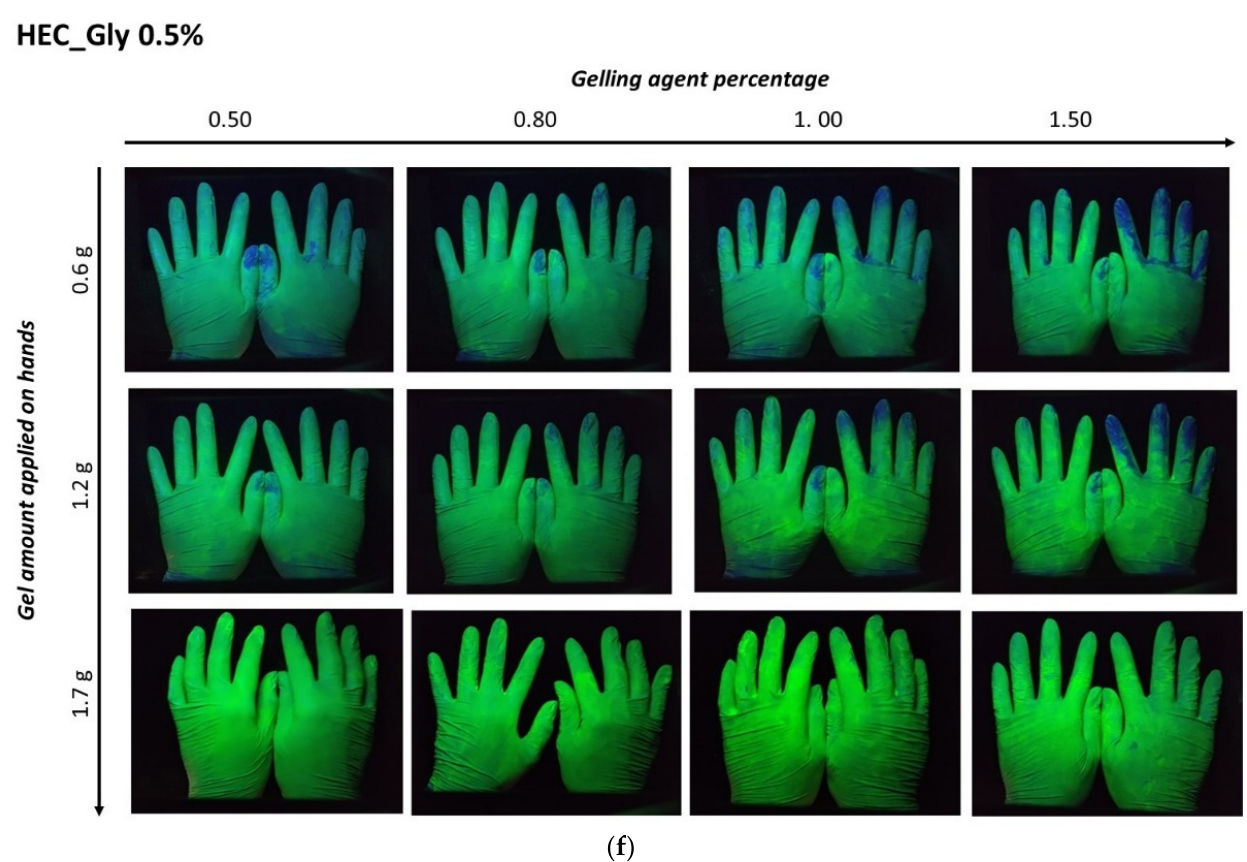
Figure 7. Distribution of fluorescent gels on hands after rubbing. ( a ) Carbopol-based gels containing 2% Glycerin (Carb_Gly 2%); ( b ) carbopol-based gels containing 0.5% Glycerin (Carb_Gly 0.5%); ( c ) HPMC-based gels containing 2% Glycerin (HPMC_Gly 2%); ( d ) HPMC-based gels containing 0.5% Glycerin (HPMC_Gly 0.5%); ( e ) HEC-based gels containing 2% Glycerin (HEC_Gly 2%); ( f ) HEC-based gels containing 0.5% Glycerin (HEC_Gly 0.5%). Representative images are shown.